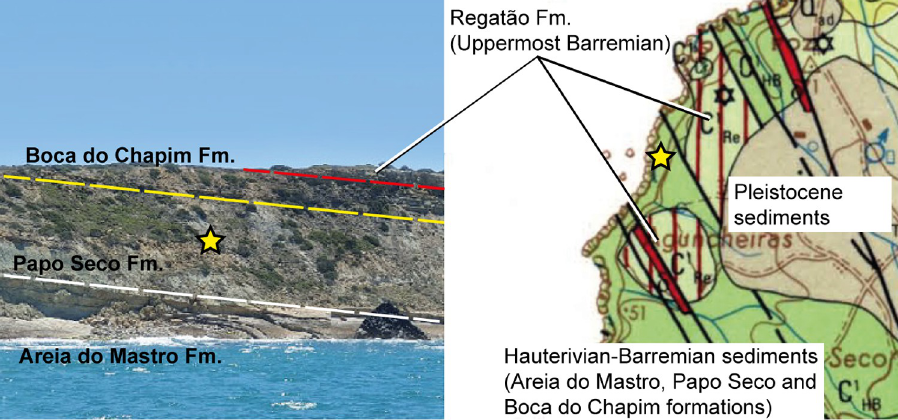
Fig 1. Geographical and geological settings of the type locality of Iberospinus natarioi (ML1190) at Praia de Aguncheiras. Left , photograph from the sea, showing the immediate geological context of the site (courtesy of Andre´ Carvalho); right , Geological map of the local area and Cretaceous outcrops (adapted from Manuppella, 1999). The site is marked with a yellow star. White line , base of Papo Seco formation; yellow line , base of Boca do Chapim formation; red line , base of Regat ã o